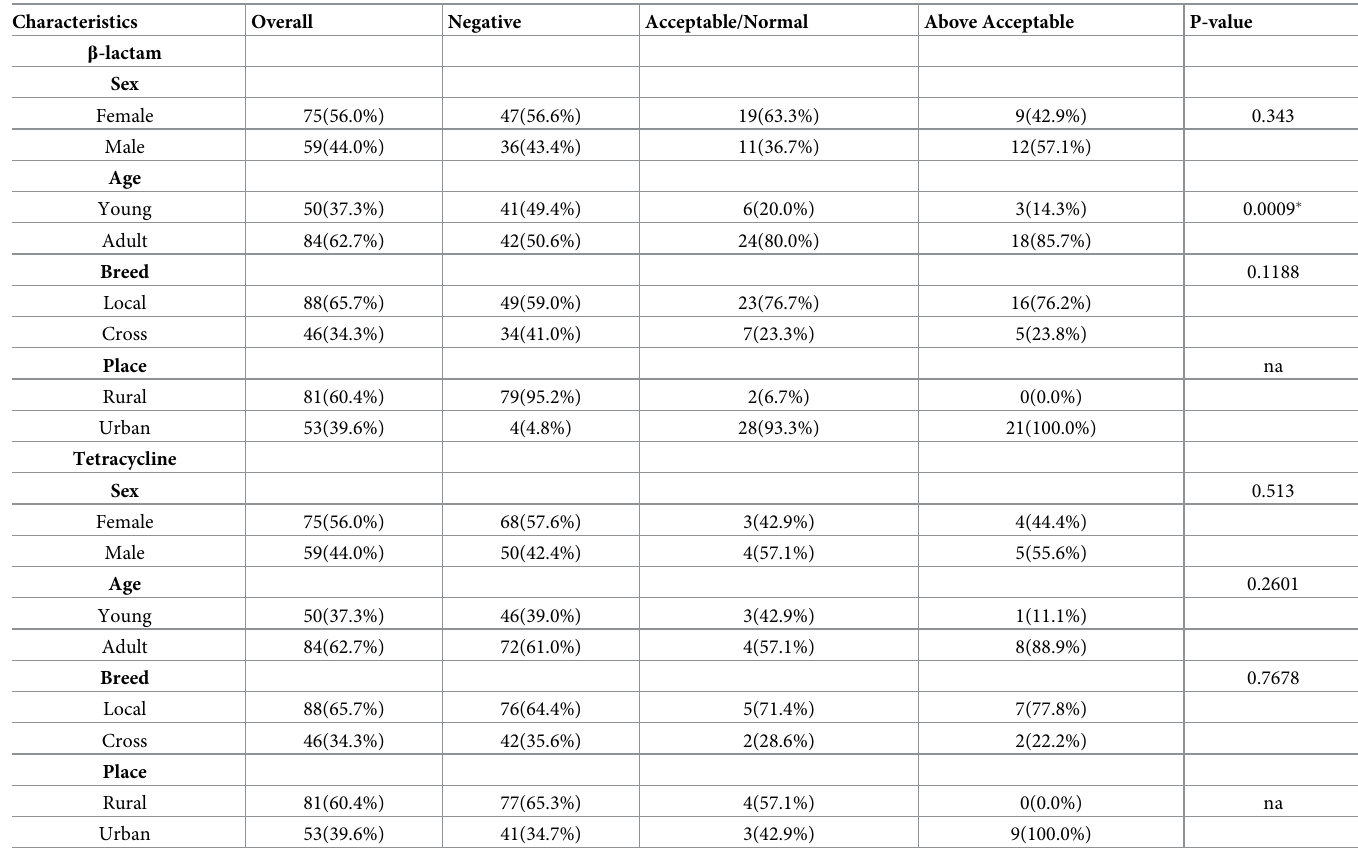
Table 3. Association of antimicrobial residues and cattle carcass